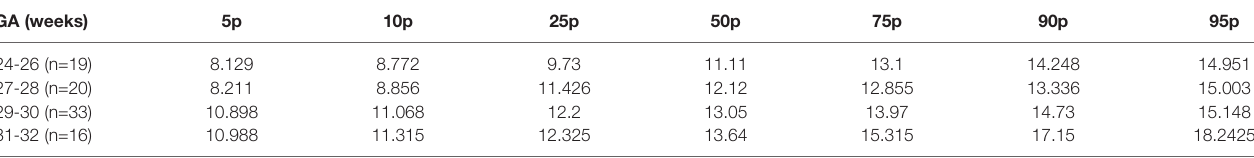
TABLE 4 | Distribution of FT4 (pmol/l) values in preterm infants born <33 weeks GA, measured at 2 weeks PNA. GA (weeks)